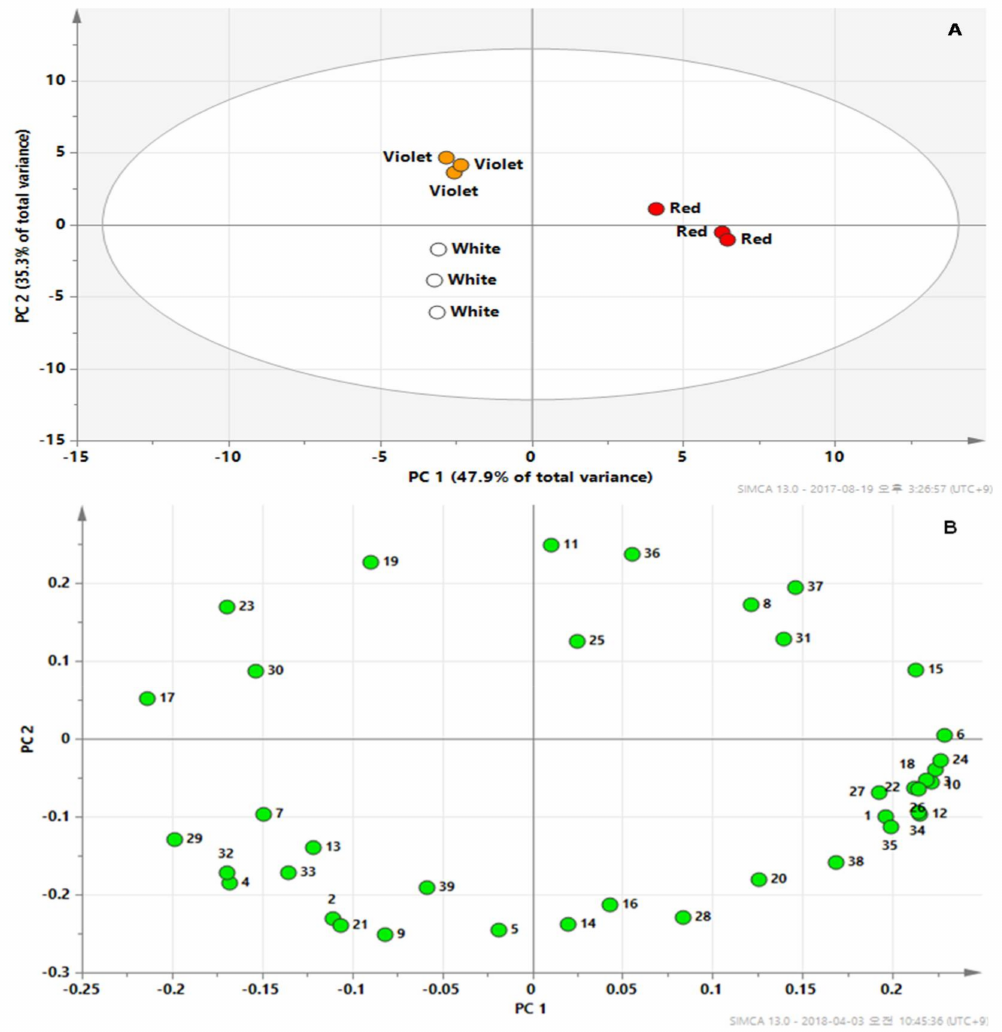
Figure 3. Scores ( A ) and loading ( B ) plots of principal components 1 and 2 of the principal component analysis results for polar metabolite data obtained for the red, violet, and white flowers of R. schlippenbachii . 1, lactic acid; 2, valine; 3, glycolic acid; 4, serine; 5, ethanolamine; 6, glycerol;